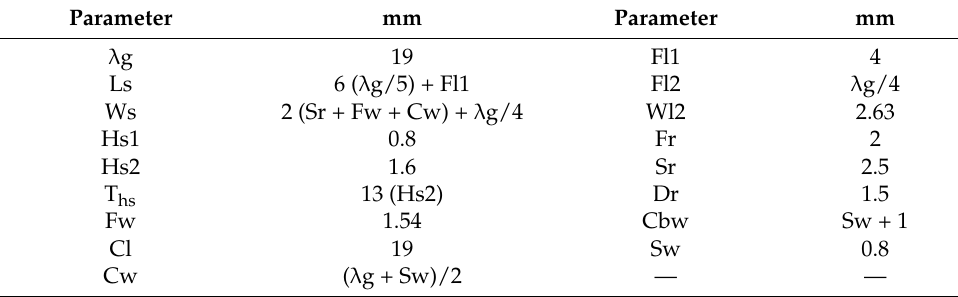
Table 1. Dimension of the proposed antenna